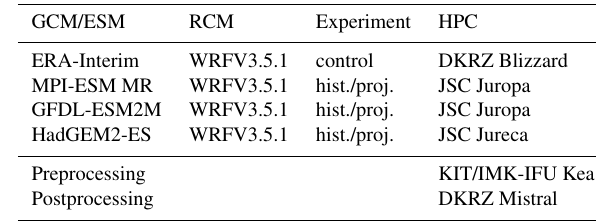
Table 3. High-performance computing systems used for the WAS- CAL high-resolution regional climate ensemble experiment. Con- trol runs are conducted for the period 1979–2014, historical runs for the period 1979–2010 (for details, see text), and RCP4.5 projec- tion runs for the periods 2019–2050 and 2069–2100.